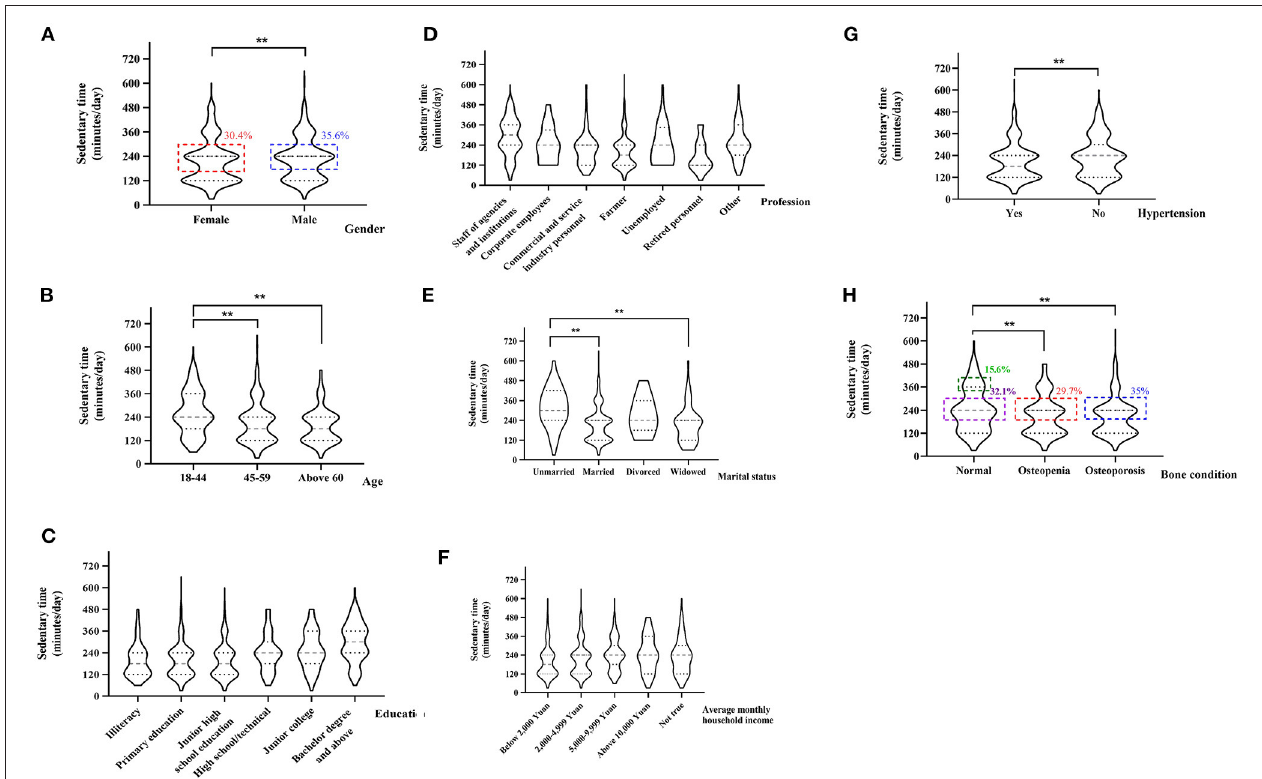
FIGURE 1 | Violin diagram of the distribution of the ST of participants different in genders (A) , ages (B) , educations (C) , professions (D) , marital status (E) , average monthly household incomes (F) , blood pressure status (G) , and bone conditions (H) . ** p < 0.01.